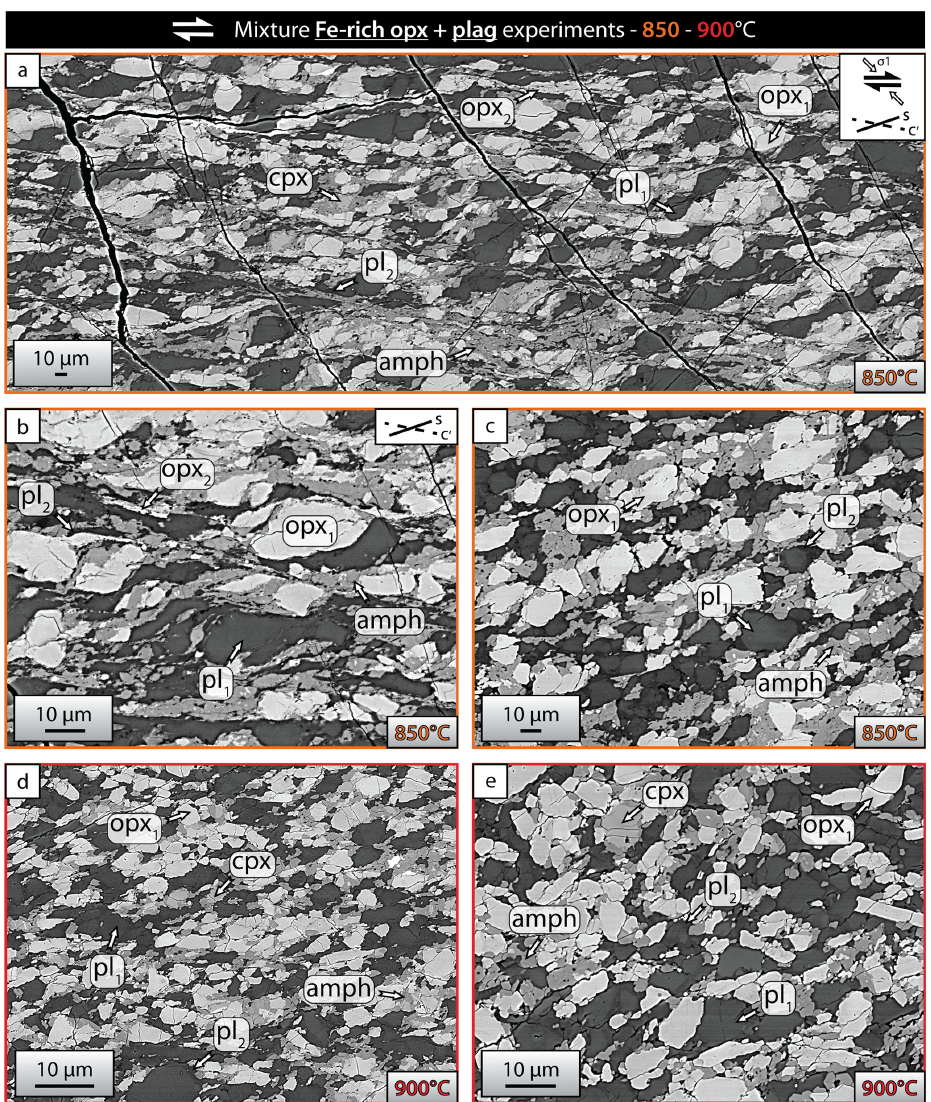
Figure 6. SEM BSE images representative of microstructures documented in deformed Fe-rich opx + plag assemblages. Amph and plag 2 are the main reaction products. At 850 ◦ C, the deformation is heterogeneously distributed, and a strain gradient is clearly apparent at sample scale. (a–b) In strongly deformed parts, the amph appears as partially connected shear bands, while in the other parts (c) it appears as thick coronas around the opx1 and plag1 clasts. (e–f) At 900 ◦ C, the deformation is more homogeneously distributed, and the reaction